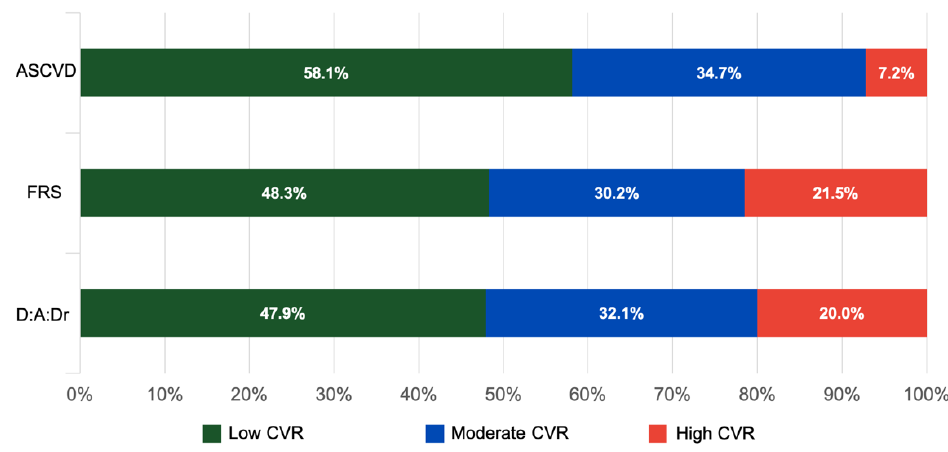
Figure 2. Prevalence of CVR according to ASCVD, FRS and D:A:Dr . Table 3. Cross-rating between risk ratings by calculators.